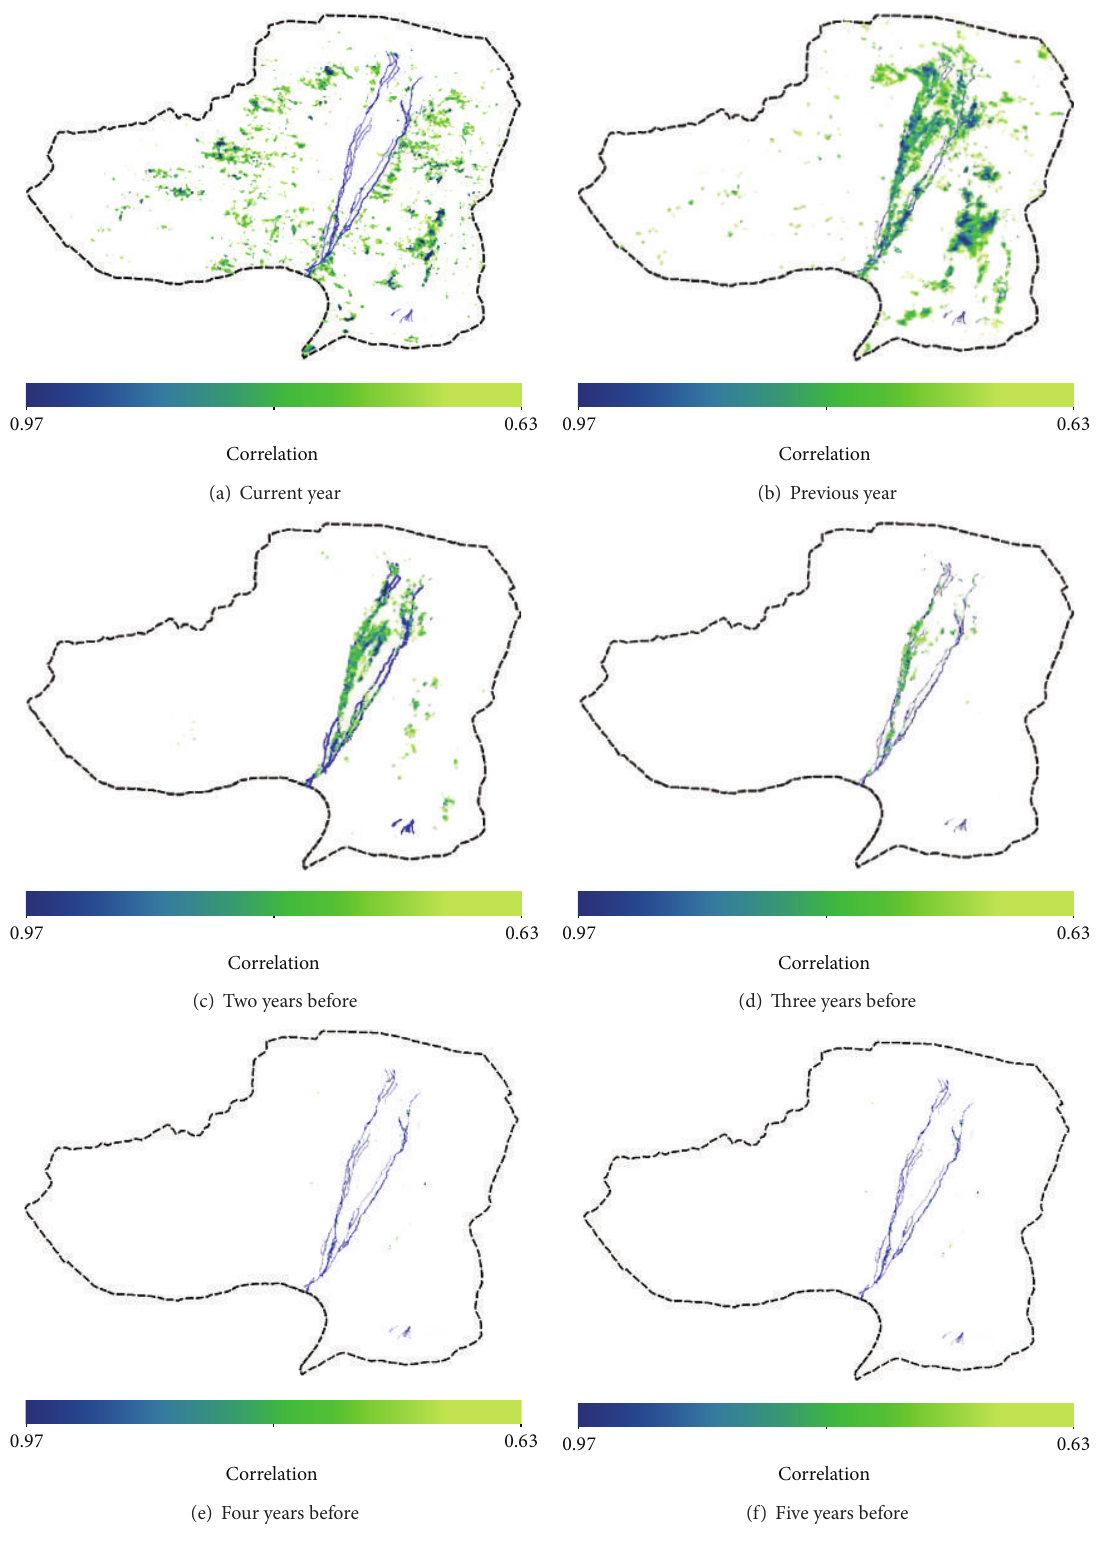
Figure 9: Vegetation sensitivities to runoff in the lower Heihe River